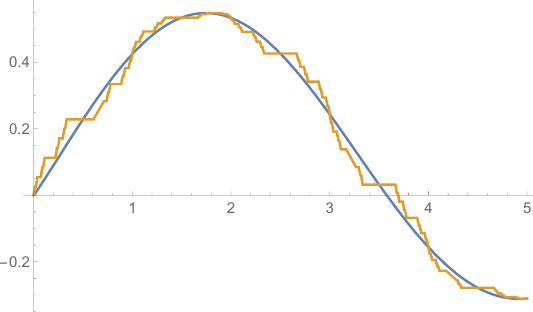
Figure 1. The local fractional solution of Equation (17) for the longitudinal displacement on Cantor coordinates ( α = 0.7 ) compared with the smooth solution ( α = 1 ) .